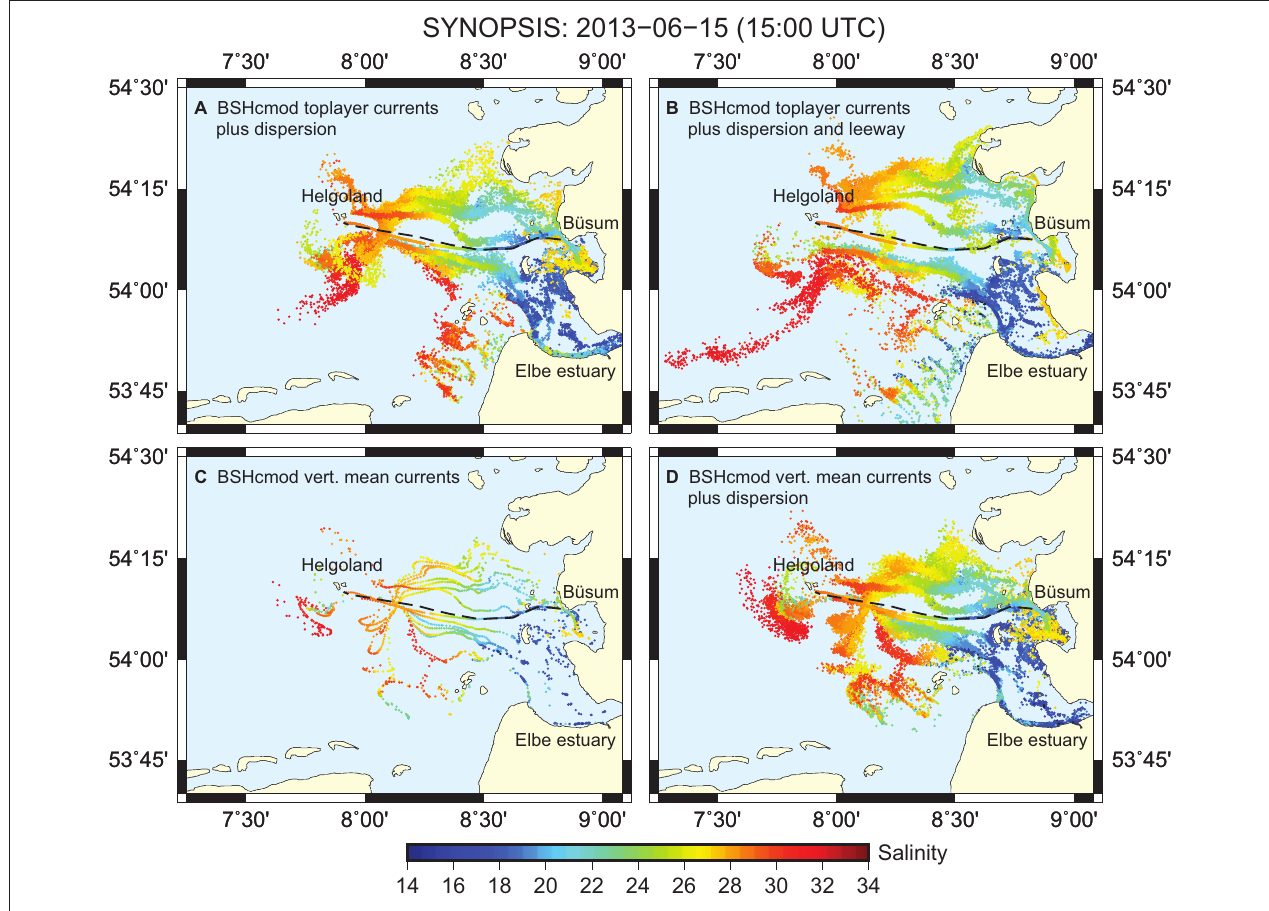
FIGURE 9 | As in Figure 4A , but generated with modified model setups: (A) Based on BSHcmod surface currents augmented with stochastic particle dispersion. In this setup, ten tracer particles per observation were released. (B) As in A, but additionally using a leeway of 0.6% of 10 m winds. (C) Simulations based on vertical mean currents. (D) As C, but adding stochastic particle dispersion. Dashed lines represent the ferry route along which all measurements were taken.